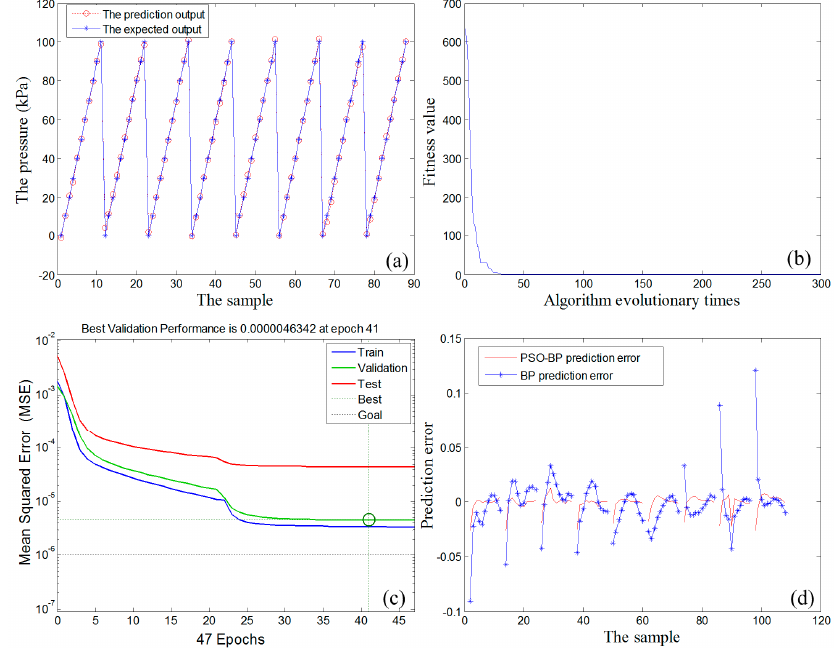
Figure 13. ( a ) The prediction output of the PSO–BP neural network algorithm; ( b ) fitness curve; ( c ) mean-squared error curve of the PSO–BP neural network algorithm; and ( d ) error curves of BP algorithm and the PSO–BP algorithm